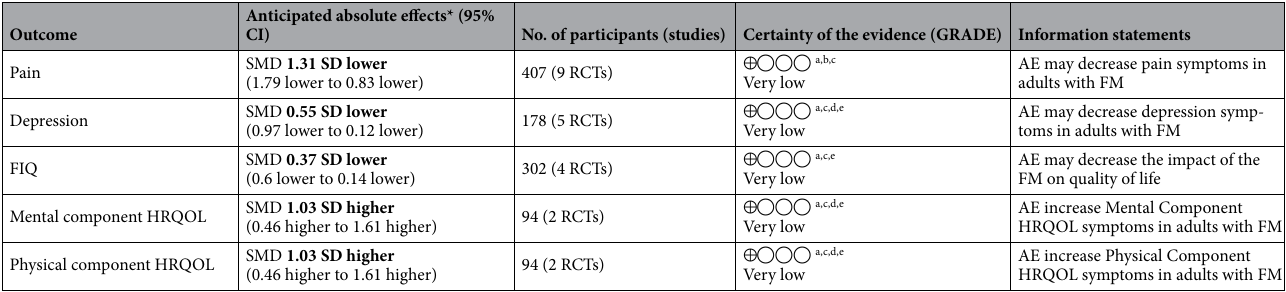
Table 1. Summary of findings table of aerobic exercise intervention for fibromyalgia symptoms in adults. Significant values are in bold. *The risk in the intervention group (and its 95% confidence interval) is based on the assumed risk in the comparison group and the relative effect of the intervention (and its 95% interval confidence). a Large number of studies with high risk of bias. b Heterogeneity present and significant. c Differences in interventions and outcomes measures. d N is under 300. e Asymmetry in the pattern of results.